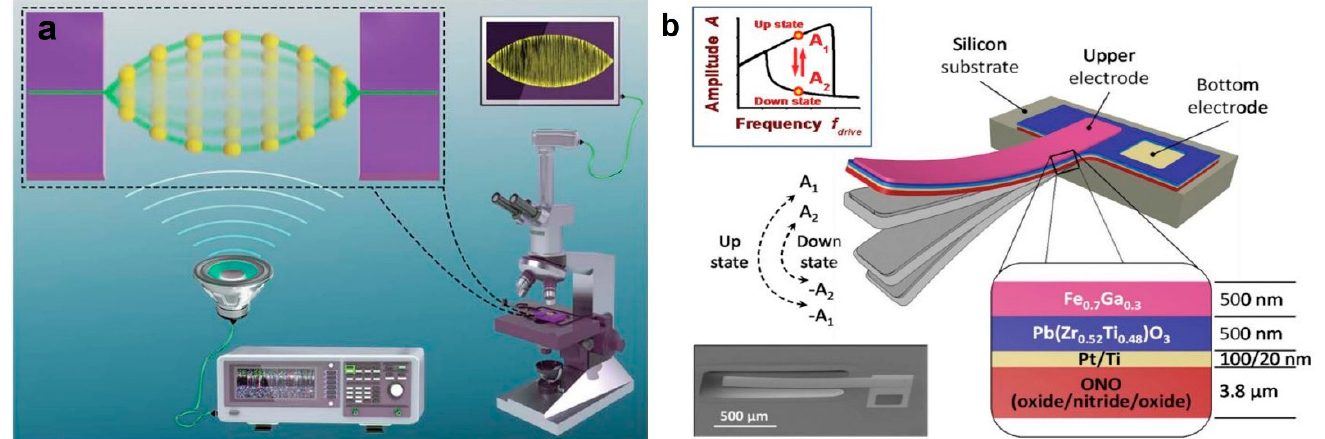
Figure 1. Acoustic and magnetoelectric coupling resonant excitation and test system. ( a ) Schematic of non-contact acoustic resonance test system. Adapted with permission from [35]. ( b ) Multi-layer heterostructure cantilever excited by magnetoelectric coupling. Top left image: SEM image of the hysteresis frequency response of multiferroic device; bottom left image: SEM image of cantilever beam. Adapted with permission from [39].